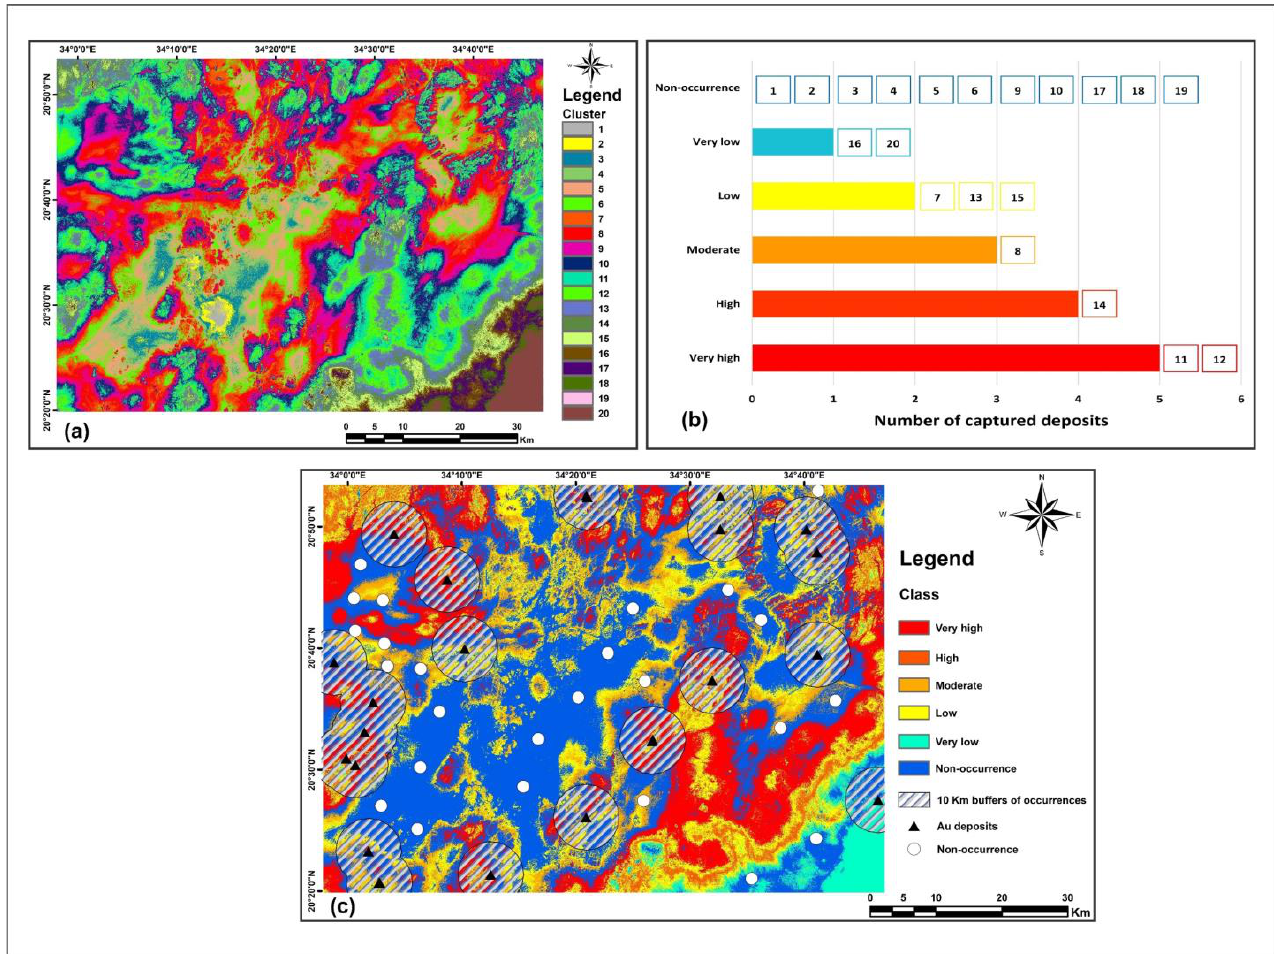
Figure 10. ( a ) K-means 20 clusters derived from ASTER and geological evidential layers.; ( b ) the number of Au occurrences spatially associated with different clusters.; ( c ) classified prospectivity clusters based on the frequency of the occurrences in each cluster obtained from ( b ).